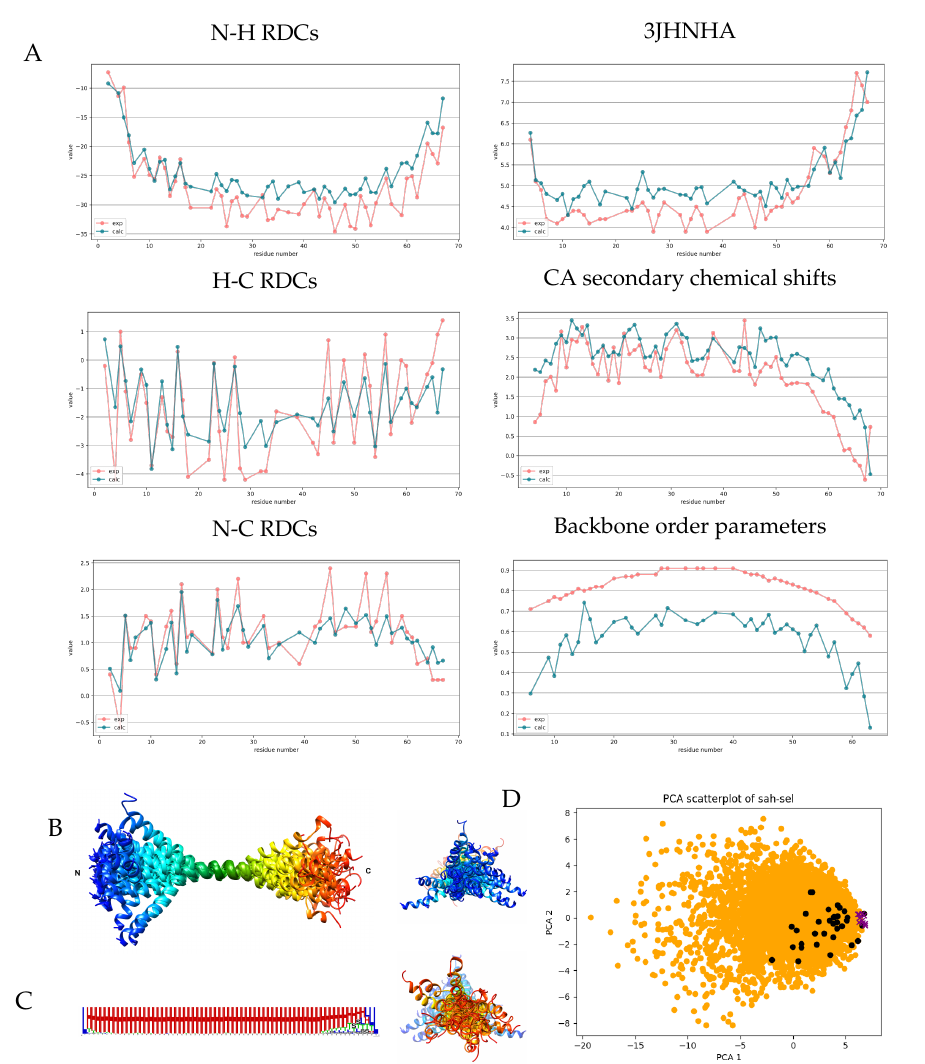
Figure 3. Measured and back-calculated NMR parameters and structural characteristics for the selected SAH ensemble. ( A ) Measured (red) and calculated (blue) values of some NMR parameters for the selected SAH ensemble. Calculated values were obtained with CoNSensX+. ( B ) Ribbon representation of the selected 37 conformers of the MYO VI SAH domain, superimposed for residues 28–42. Rainbow coloring from N to C terminus. Figure prepared with UCSF Chimera. ( C ) Secondary structure logo generated from averaging all DSSP state probabilities calculated with DSSPcont for all 37 models. Figure prepared with Weblogo. ( D ) PCA plot showing the distribution along modes 1–2 of the generated 5000 (orange), the selected 37 (black) structures and the 10 deposited conformers in PDB entry 6OBI (purple). Mode 1 corresponds to the end-to-end distance of the